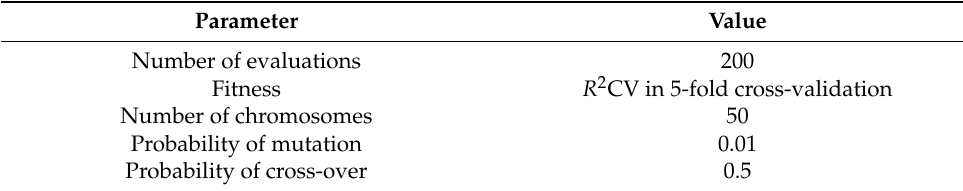
Table 2. Parameters of Genetic algorithm. Parameter